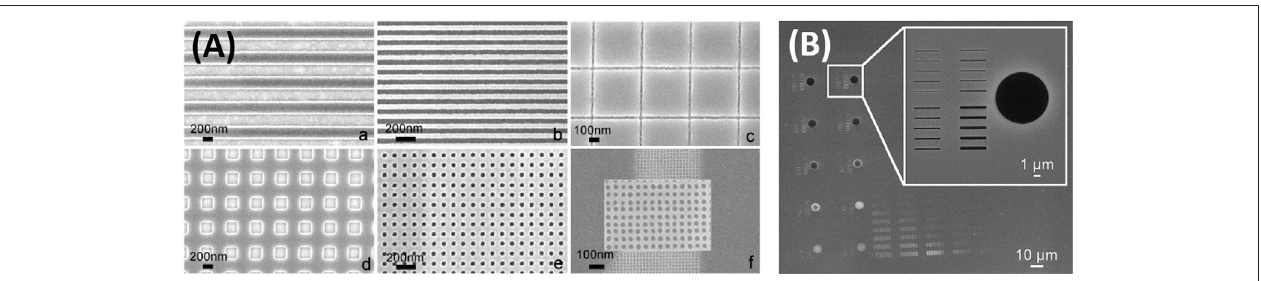
FIGURE 2 | (A) phenyl-bridged polysilsesquioxane (ph-PSQ), for use as a new high resolution resist for electron beam lithography. Reprinted from Brigo et al. (2012),Copyright(2012),withpermissionfromElsevier. (B) Examplesofhighresolutionfeatures(lessthan100 nm).ReprintedfromDellaGiustinaetal.(2007),Copyright (2007), with permission from Elsevier.